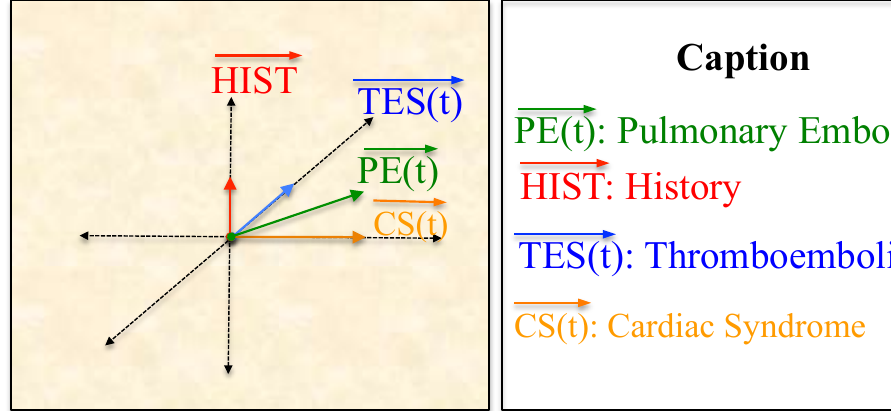
Figure 25. Pulmonary embolism’s variables evolution from suspicion to diagnosis. The corresponding FVS of pulmonary embolism −−−−→ −−−→ −−−→ HIST , TES ( t ) and CS ( t ) , as shown on Figure 26. Note that can just be updated in the case of missing data. As indicated from Table 2, history remains stable, while the thromboembolic syndrome and the cardiac syndrome evolve, and thus, −−−→ PE ( t ) , corresponding to the pulmonary embolism indicator, is changing the resultant vector over the time.